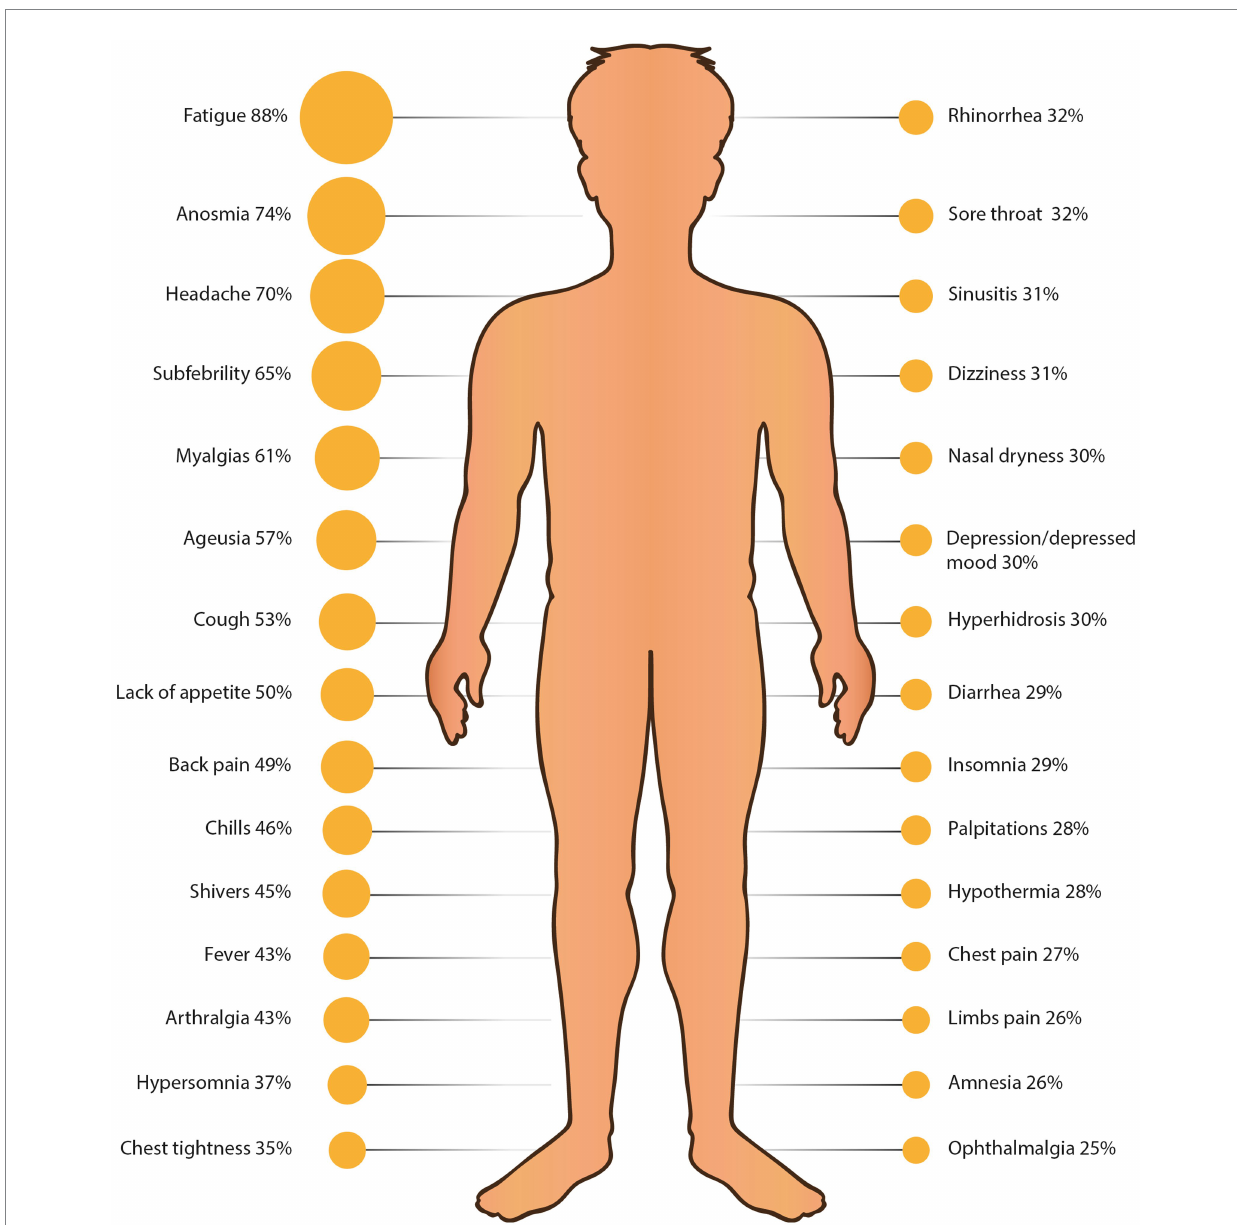
FIGURE 2 Thirty most common COVID-19 symptoms reported by survey participants. Man figure source: freepik.com.